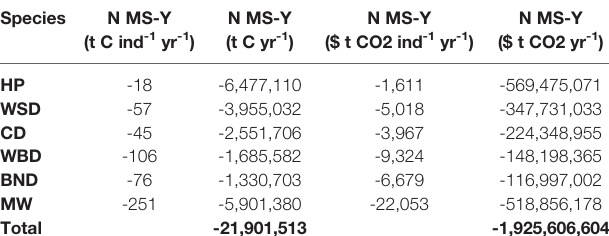
TABLE 7 | Cetacean driven N MS-Y carbon fl uxes and